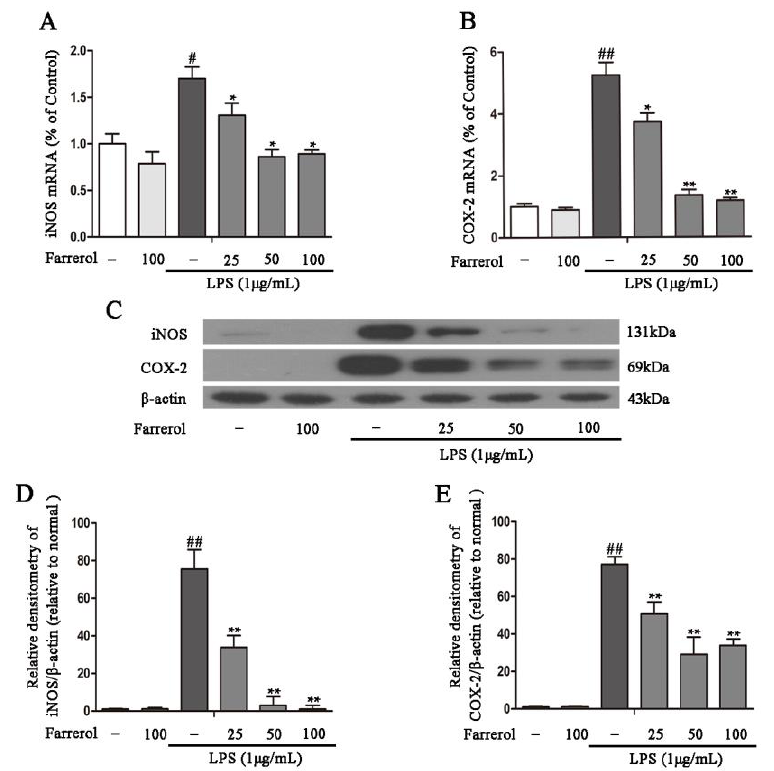
Figure 5. Farrerol inhibits inflammatory enzymes production in LPS-induced RAW264.7 cells. The cells were incubated with Farrerol for 1 h before LPS stimulated for 6 h or 12 h. Total RNA was extracted from cells by Trizol following LPS stimulated for 6 h. The mRNA levels of COX-2 and iNOS were examined by quantitative real-time PCR ( A , B ) ( n = 3). The protein levels of COX-2 and iNOS were detected by western blot following LPS stimulated for 12 h ( C – E ) ( n = 3). # p < 0.05 and ## p < 0.01 compared to the control group, * p < 0.05 and ** p < 0.01 compared to the LPS group, and statistical significance was determined by ANOVA.